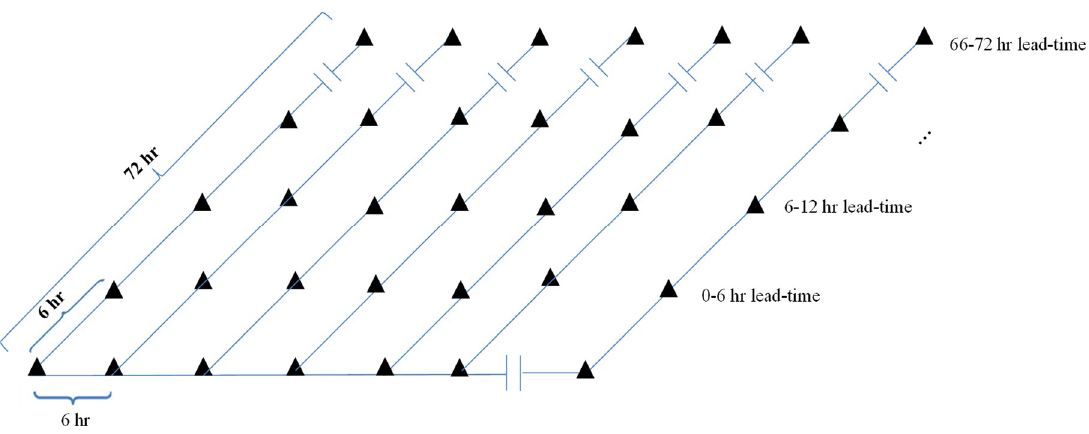
Figure 2. The schematic construction of the real-time forecast of the WRF model.